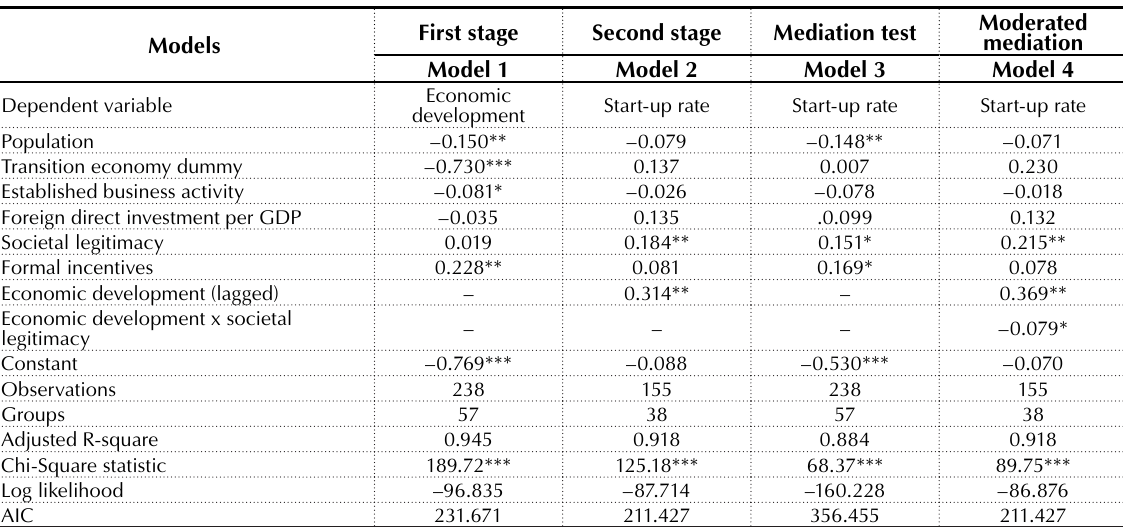
Table 2. Regression